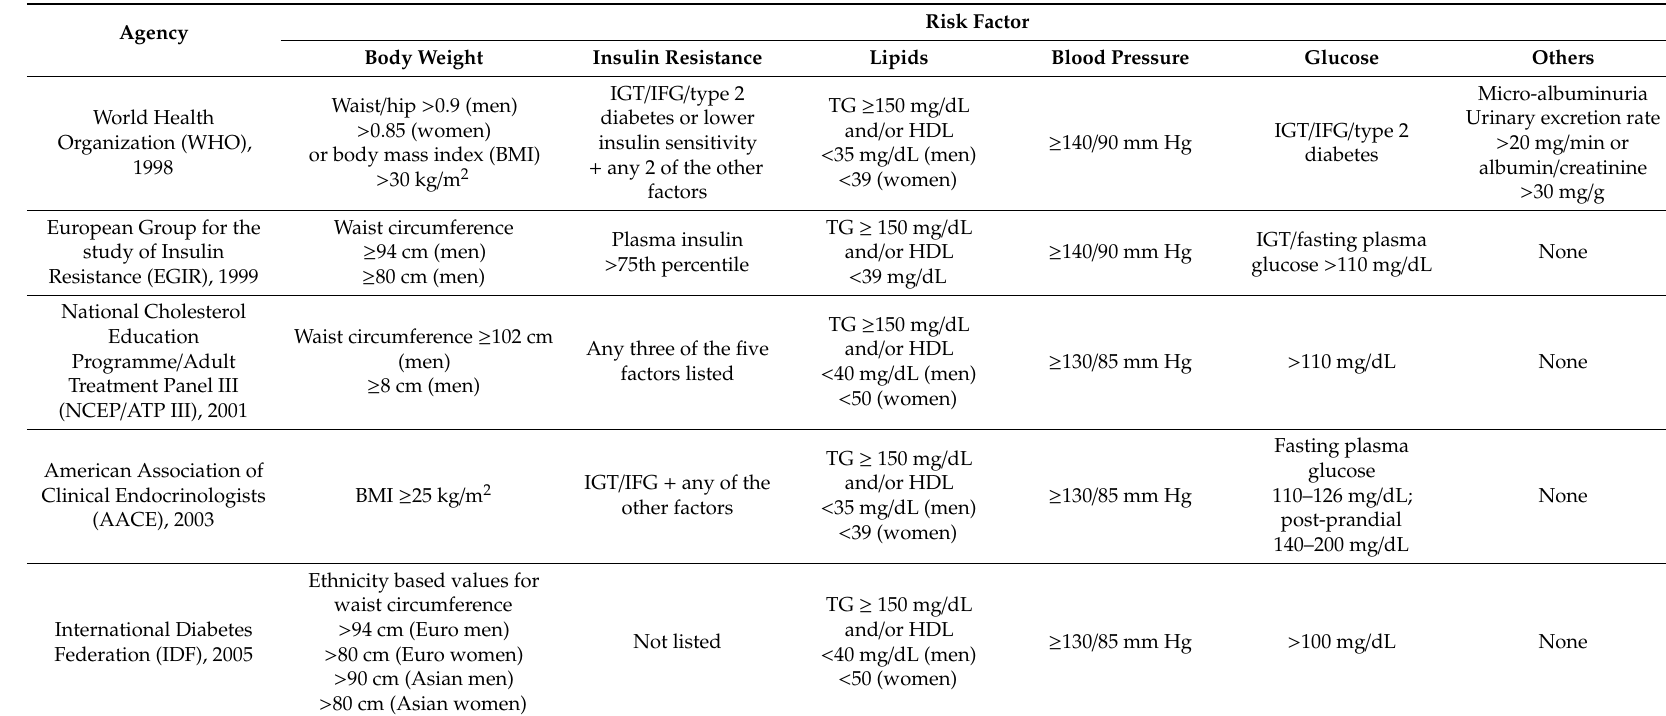
Table 2. Various diagnostic criteria used for